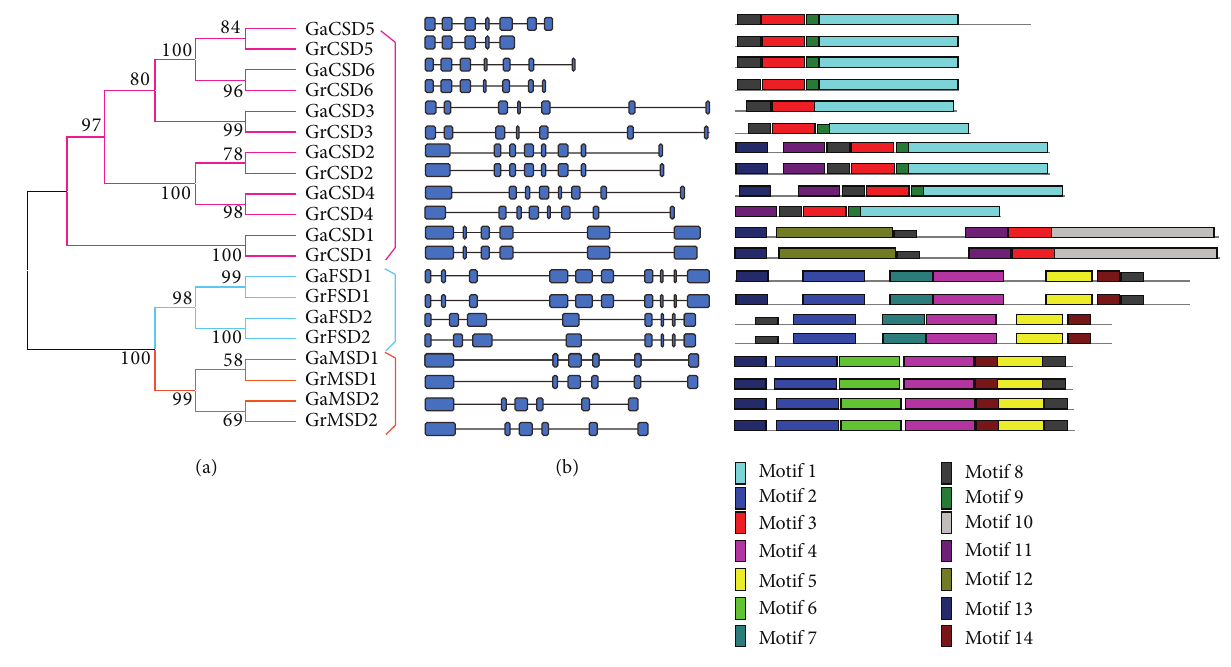
Figure 3: Phylogenetic analysis, gene structure, and conserved motifs of SOD gene family in cotton. (a) The phylogenetic tree of all SOD genes in Gossypium arboreum . (b) The exon/intron organization of SOD genes in Gossypium arboreum . The green boxes represent exons and black lines indicate introns. (c) The conserved protein motif of SOD gene family was identified. Each motif is indicated with a specific